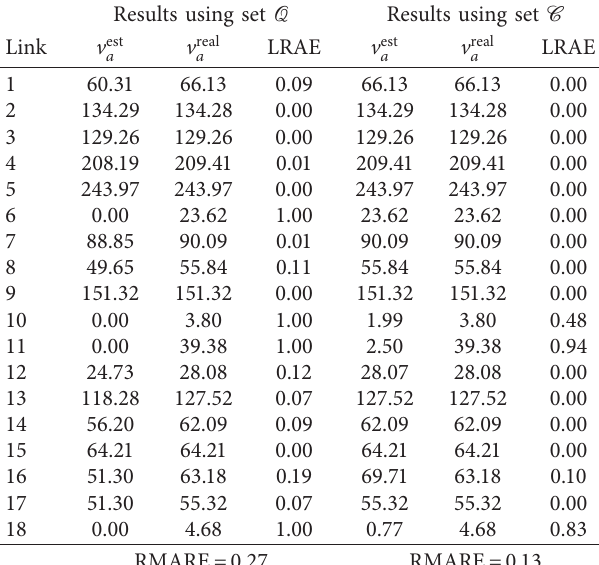
Table 3: Link flow in estimated and real situations and relative absolute error value. Results using set Q Results using set